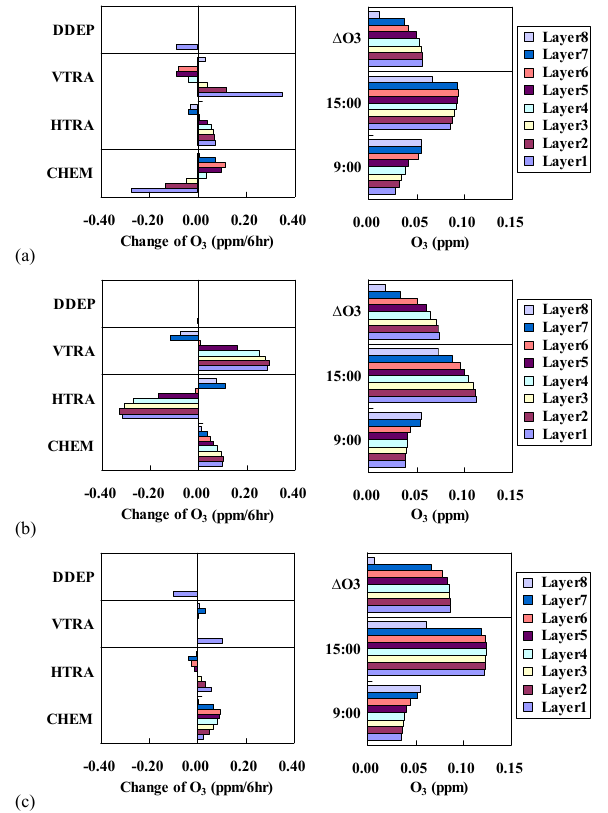
Fig. 9. O 3 change rates due to various atmospheric processes for layers 1 to 8 (left) and evolution of O 3 vertical profiles (right) at (a) GDEMC, (b) Xinken, and (c) Donghu from 09:00 to 15:00LST av- eraged for 16–22 October 2004. (VTRA: vertical transport, the net effect of vertical advection and diffusion; HTRA: horizontal trans- port, the net effect of horizontal advection and diffusion; DDEP: dry deposition; CHEM: gas-phase chemistry; 1 O3: the change of O 3 concentrations from 09:00 to 15:00LST).